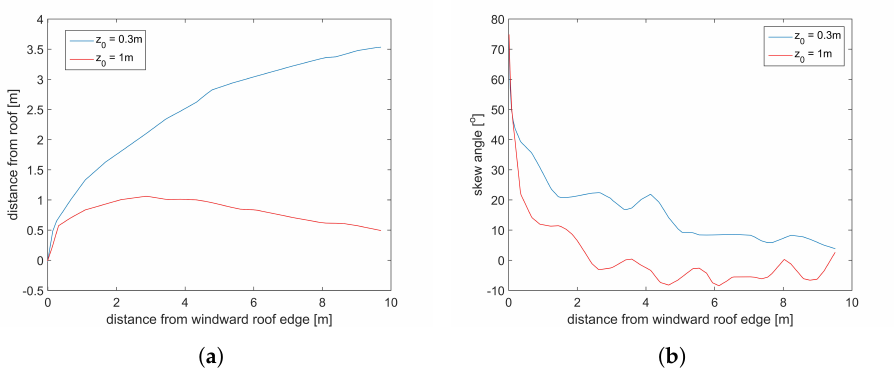
Figure 5. Separation streamlines and skew angle above the roof for different roughnesses. Figures are adapted from Mertens [13]. ( a ) Separation streamlines above the roof. ( b ) Skew angle above the roof.